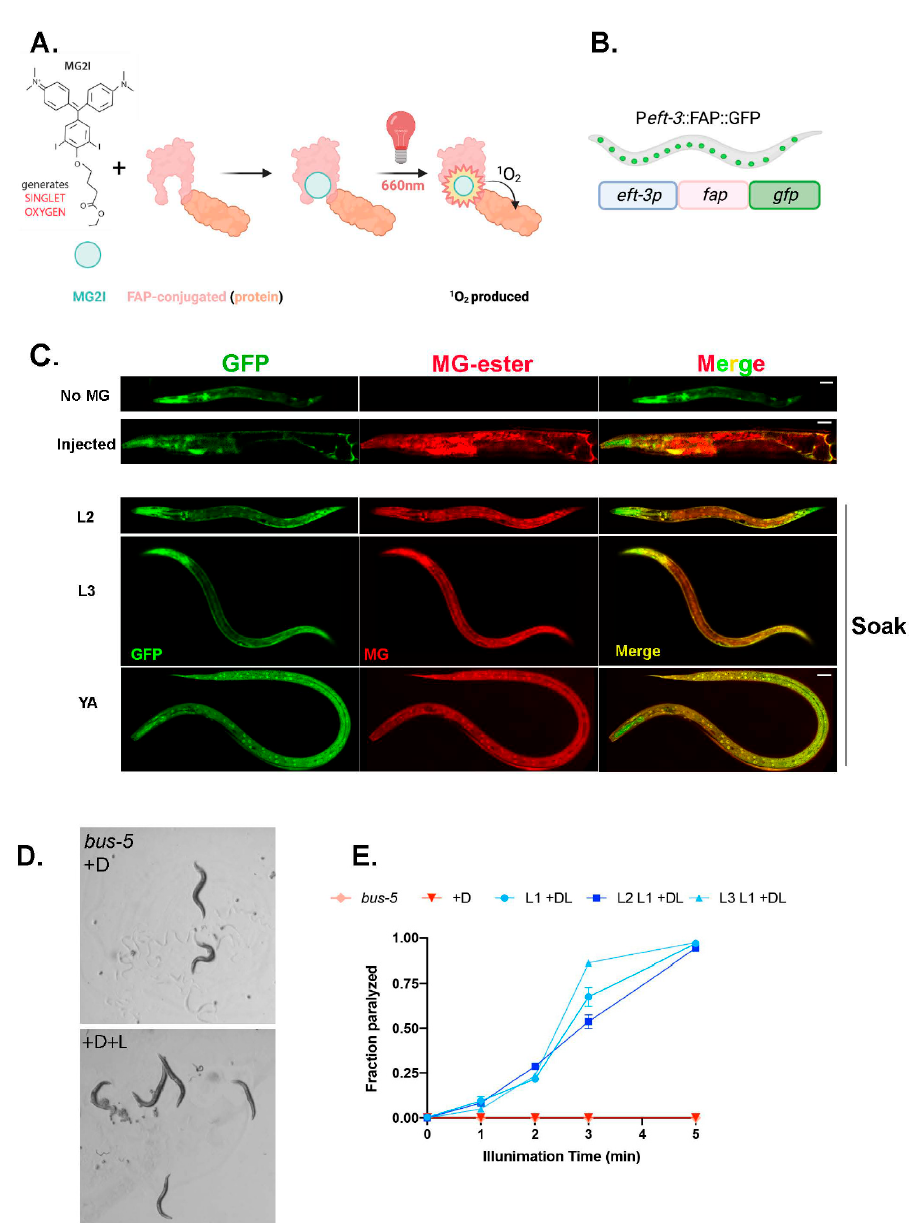
Figure 1. MG-2I-chemoptogenetic tool ( A ) Schematic of chemoptogenetic tool. MG-2I derivative generates 1 O 2 upon excitation with light. FAP can be tagged to any protein to target to specific cells or tissues. Once MG-2I binds to FAP and is illuminated with 660 nm far-red light, it generates singlet oxygen. Since 1 O 2 has limited permeability and is highly reactive, it will react in the immediate vicinity of its generation. ( B ) Schematic of eft-3p::fap::gfp in bus-5 ( C ) Colocalization of GFP and MG-ester dye in transgenic bus-5 worms. Top—no MG dye as negative control, D1 adults injected with MG-ester (200 µ M) as positive control. Larvae (L2, L3) and young adults (YA) soaked in MG-ester (2 µ M final concentration) for 24 hr. Scale bar is 25 µ m. ( D ) Representative images of bus-5 transgenic worms immediately after red light illumination. Light in the wavelength of 660 nm results in paralysis only in dye fed animals; dye only does not impact locomotion. ( E ) Paralysis rate quantified of 3 independent lines of eft-3p::fap::gfp in bus-5, and bus-5 parental strain after 24 hr soak with MG-2I (2 µ M final) and illuminated with red light (660 nm) for indicated time. A total